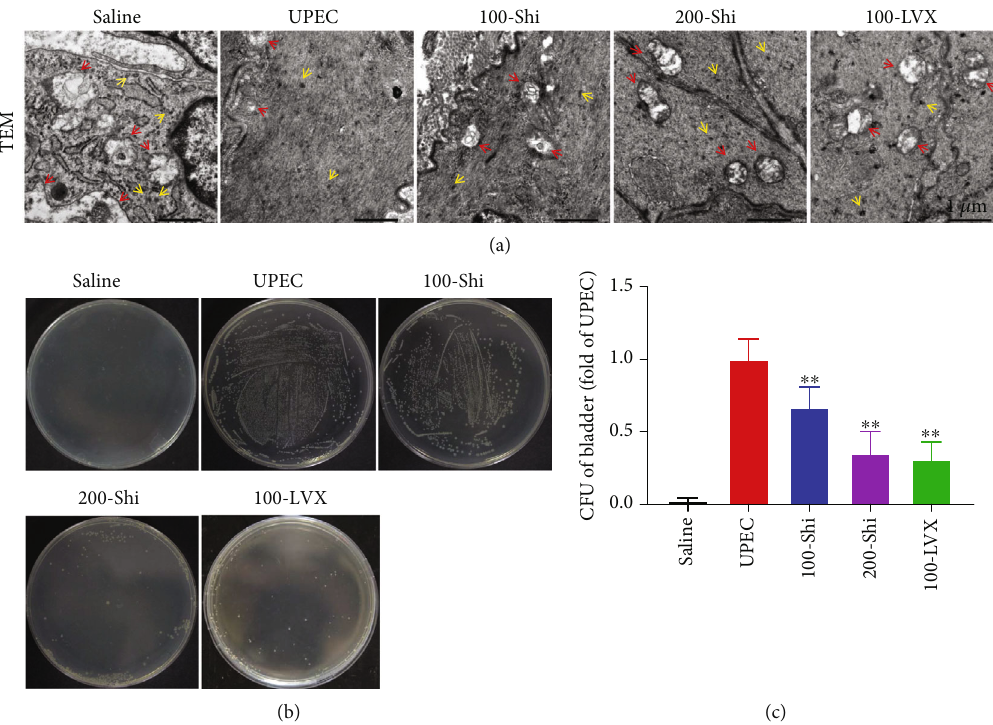
Figure 2: Shionone decreases the number of bacteria. (a) Electron micrograph of bladder tissue, with red arrows pointing to vesicles and yellow arrows to lysosomes. The magni fi cation scale is 8000x, and the scale added to the images is 1 μ m. (b) Bacterial colony counts in bladder homogenates of rats in each group. The magni fi cation scale is 400x, and the scale added to the images is 100 μ m. (c) Histogram statistics of bacterial CFU in bladder homogenates of rats in each group. Compared with the saline group, # means p < 0 : 05 and ## means p < 0 : 01 . Compared with the UPEC group, ∗ means p < 0 : 05 and ∗∗ means p < 0 : 01